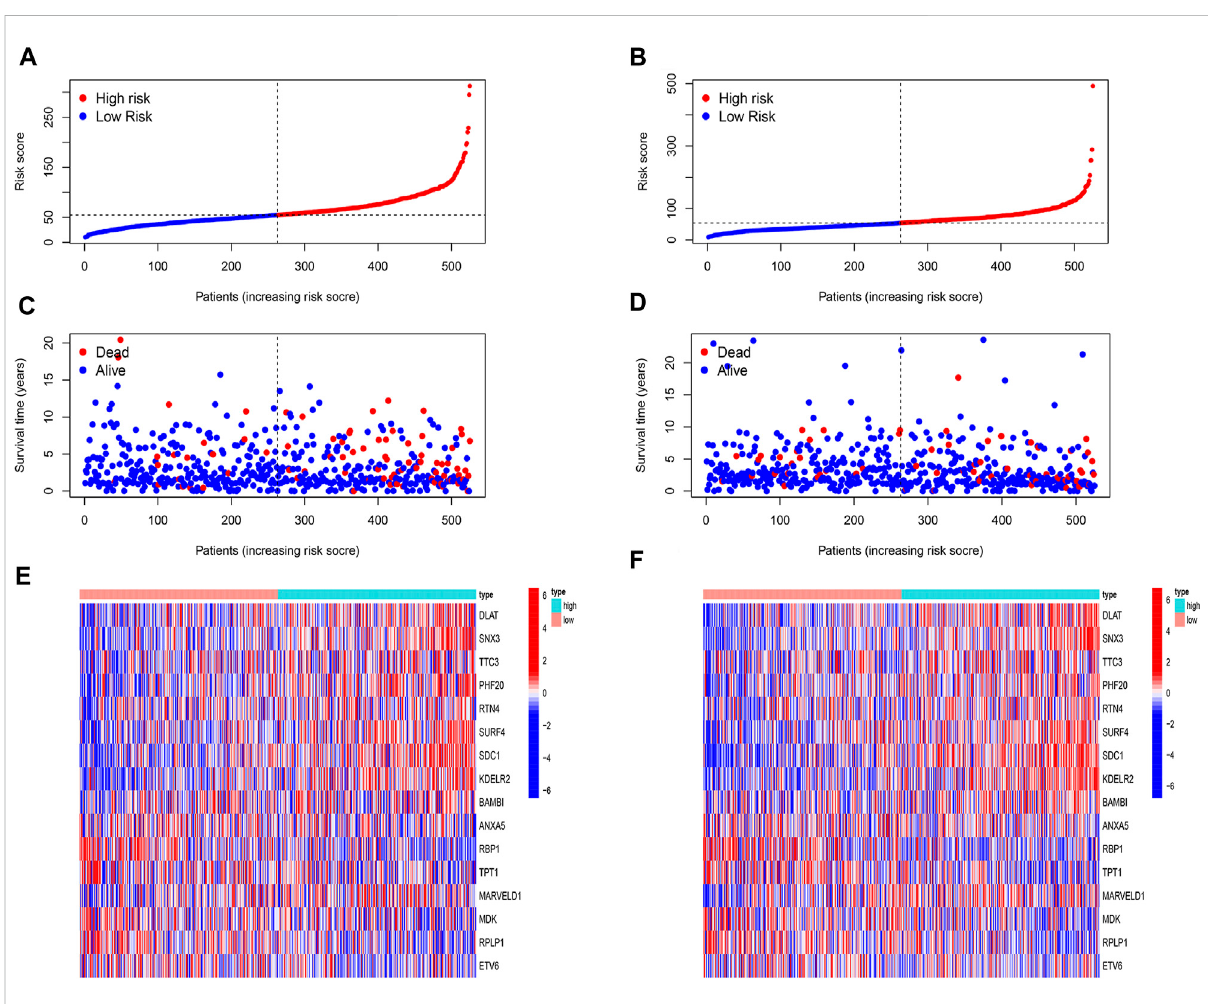
FIGURE 5 Evaluation of prognostic model. (A,B) The risk score of both cohorts. The patients were divided into high-risk and low-risk groups based on the median risk score. (C,D) The correlation of risk score and survival status of patients in both cohorts. With the increase in risk value, the proportion of BC patients who died increased. (E,F) Heat map of expression of 16 model genes in high-risk and low-risk in both cohorts. The genes ANXA5 , RBP1 , TPT1 , MDK , RPLP1 , and ETV6 were highly expressed in the low-risk group, while DLAT , SNX3 , TTC3 , PHF20 , RTN4 , SURF4 , SDC1 , KDELR2 , BAMBI, and MARVELD1 were highly expressed in the high-risk